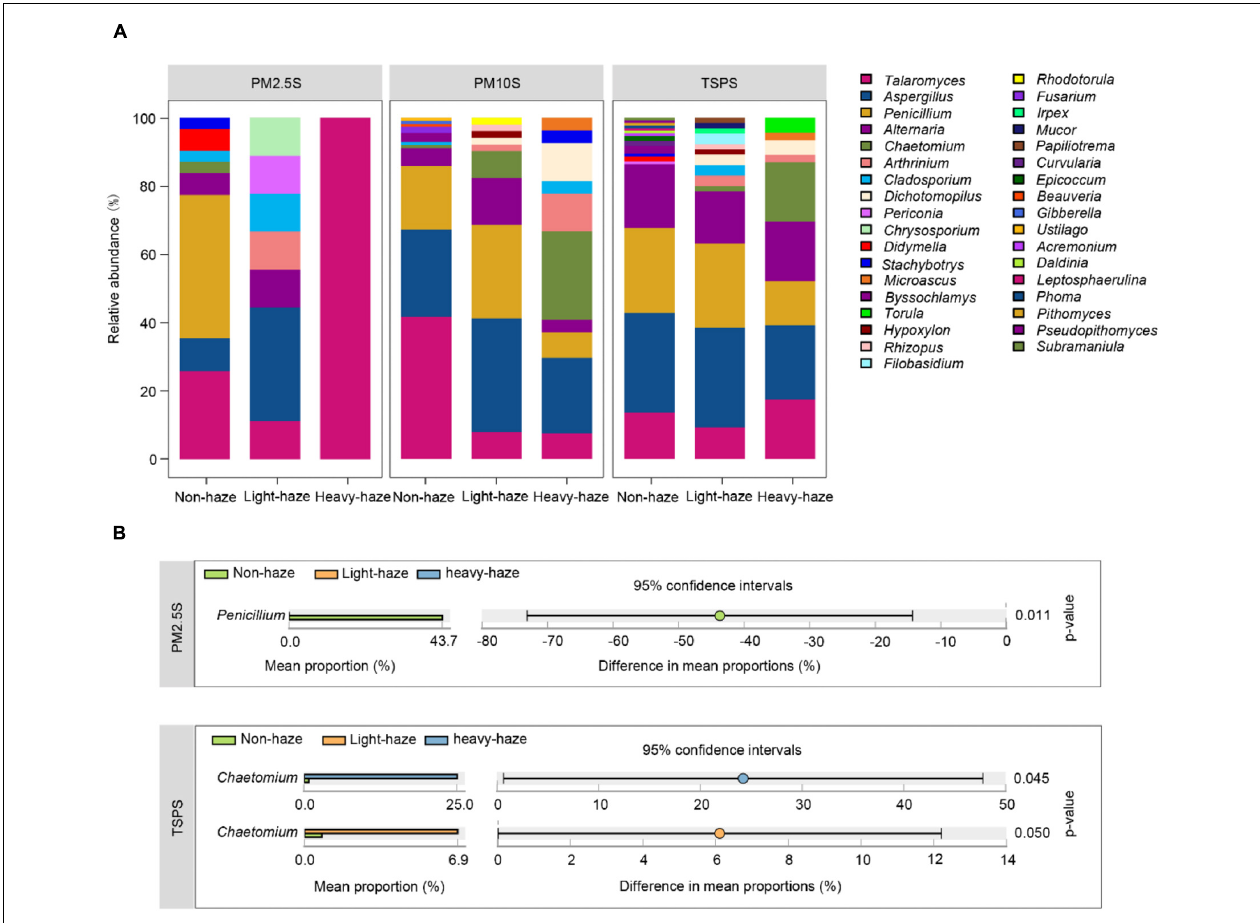
FIGURE 5 | Fungal diversity and composition among various PMs during non-, light-, and heavy-haze days. (A) Bar plot indicating relative abundances of fungal genera among PMs. (B) STAMP analysis indicated genera that were significantly different among various haze-level samples.